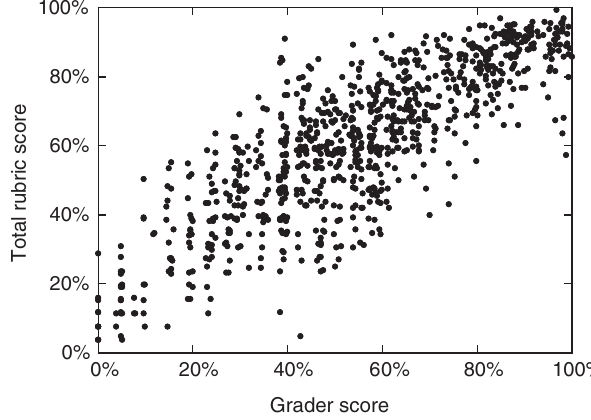
FIG. 5. Scatter plot of total rubric score vs TA grade for all eight midterm problems ( N ¼ 918 ). The correlation ( ρ ) between the two scores is 0.82 ( p < 0 . 0001 ). Points are shifted by a small random number so as not to mask clusters of scores.